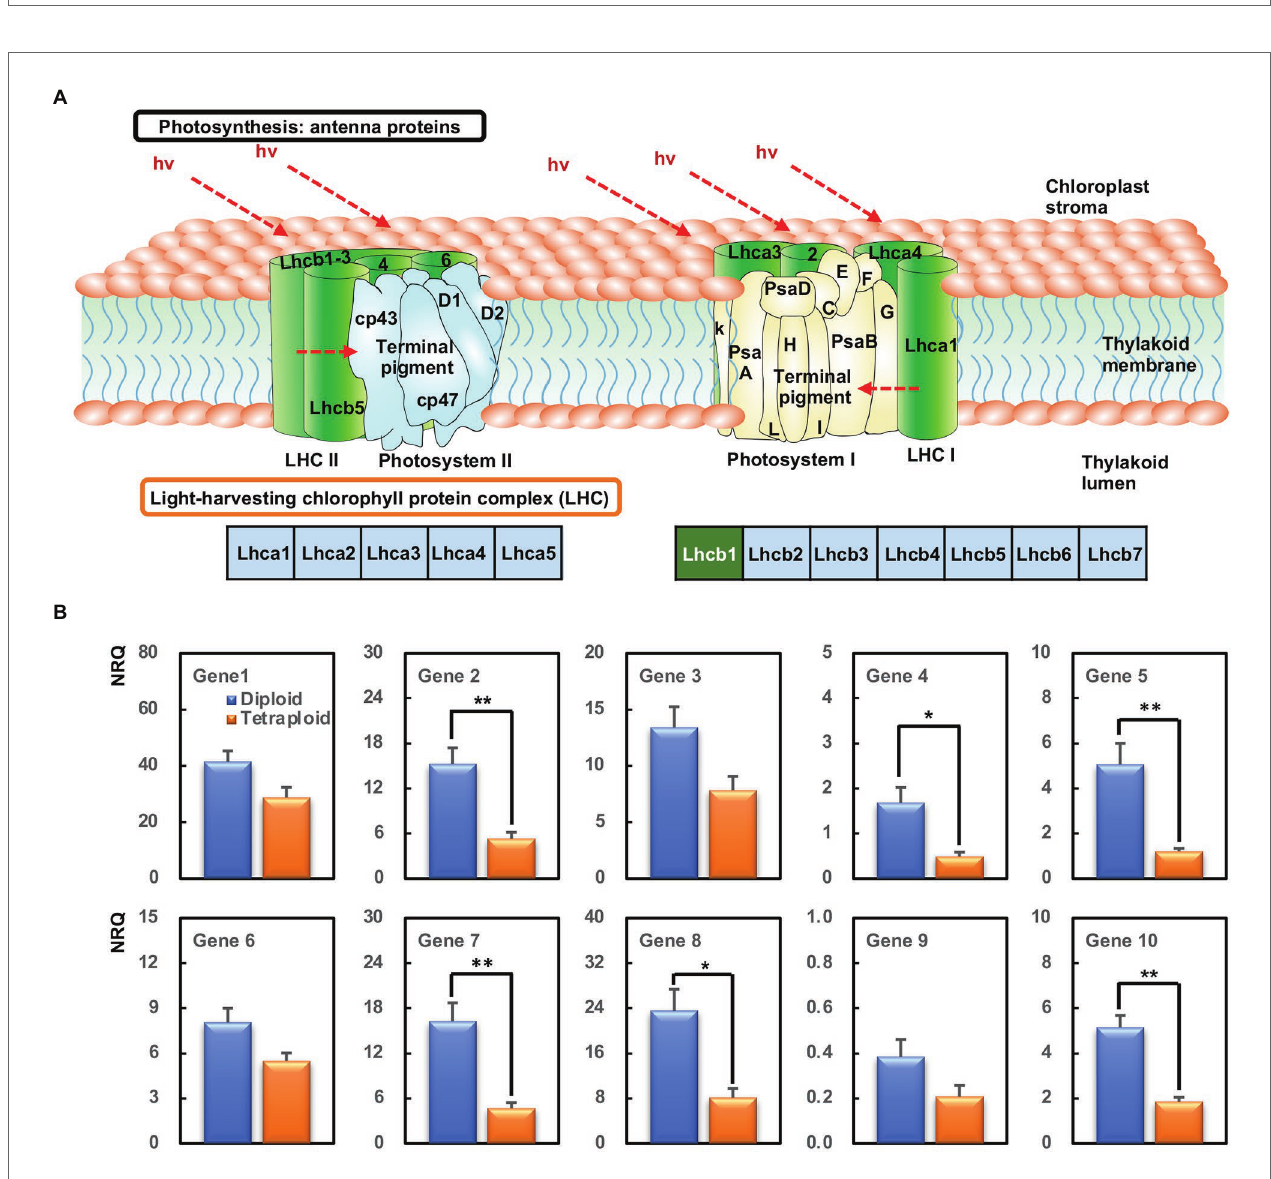
FIGURE 5 | taurine and hypotaurine metabolism; 00410: beta-alanine metabolism; 00360: phenylalanine metabolism; 00350: tyrosine metabolism; 00330: arginine and proline metabolism; 00270: cysteine and methionine metabolism; 00260: glycine, serine, and threonine metabolism; 04216: ferroptosis; 03450: non-homologous end-joining; 00944: flavone and flavonol biosynthesis; 00930: caprolactam degradation; 00902: monoterpenoid biosynthesis; 00830: retinol metabolism; 00780: biotin metabolism; 00750: vitamin B6 metabolism; 00710: carbon fixation in photosynthetic organisms; 00643: styrene degradation; 00630: glyoxylate and dicarboxylate metabolism; 00627: aminobenzoate degradation; 00561: glycerolipid metabolism; 00514: other types of O-glycan biosynthesis; 00450: selenocompound metabolism; 00333: prodigiosin biosynthesis; 00220: arginine biosynthesis; 00196: photosynthesis-antenna proteins; 00061: fatty acid biosynthesis.